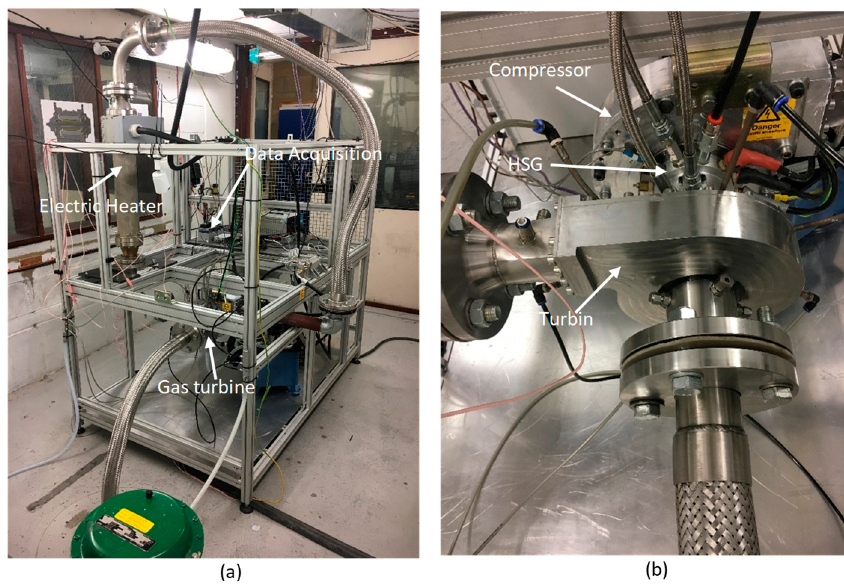
Figure 3. ( a ) MGT test rig installed at City, University of London, and ( b ) the gas turbine used in the test with the main components pointed out.